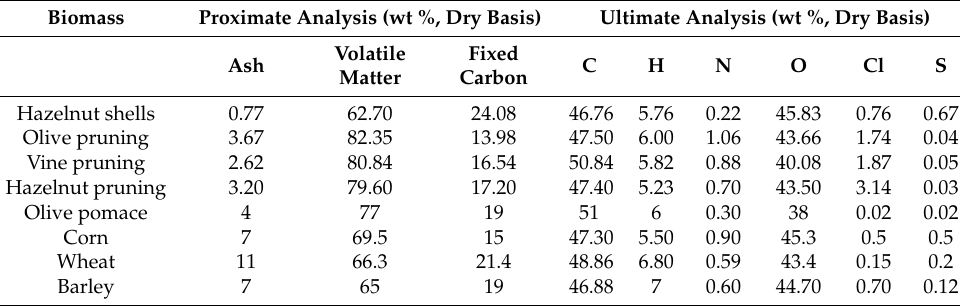
Table 3. Biomass proximate and ultimate